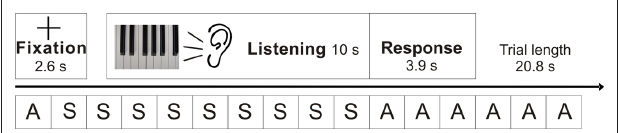
FIguRe 1 | schematic representation of events in an experimental trial. Participants first saw a fixation cross and the task instruction (“melody improvised?”). Thereafter, a 10-s excerpt of a melody was presented with backing during the silent period (silent volumes, S) of the event-related fMRI sparse sampling procedure. Finally, seven functional whole brain scans were recorded (active volumes, A) and participants indicated by key press whether they believed that the melody was improvised